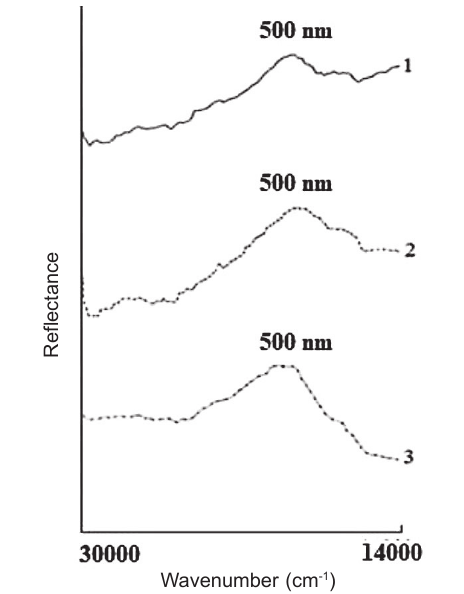
Fig. 2 – Diffuse reflectance spectra of (1) Ni(II) MMT react- ed with pyrrole and 4-carboxyrenzaldehyde, (2) Fe(III) MMT reacted with pyrrole and l-naphthaldehyde, (3) Fe(III) MMT reacted with pyrrole and cinnamaldehyde